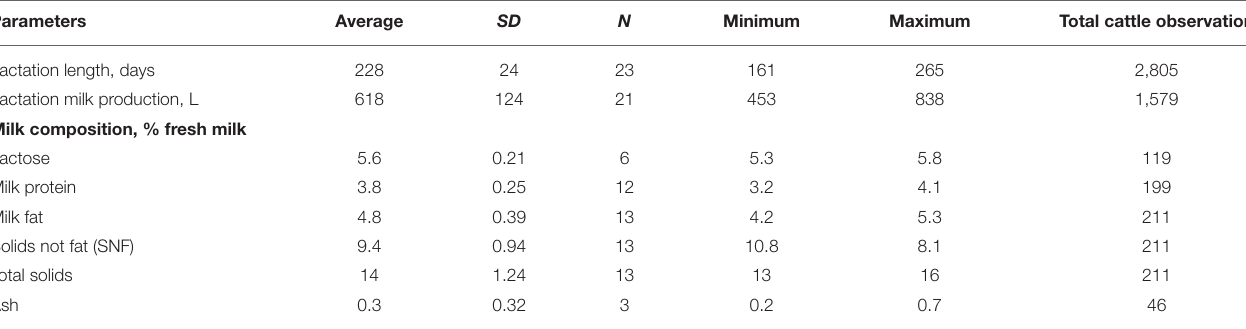
TABLE 6 | Milk production of Red Chittagong cattle and its composition.